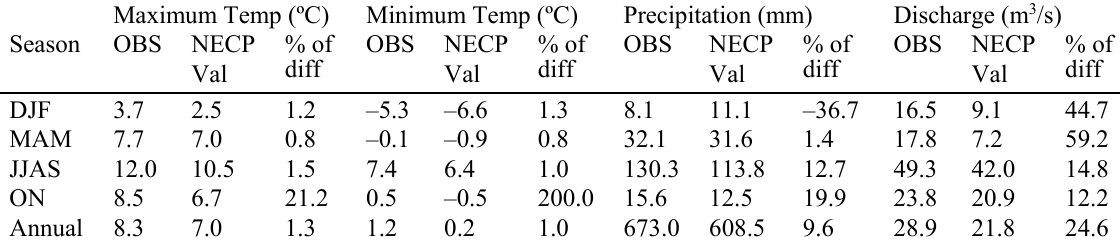
Table 2 Validation of observed data with CGCM3 of NCEP